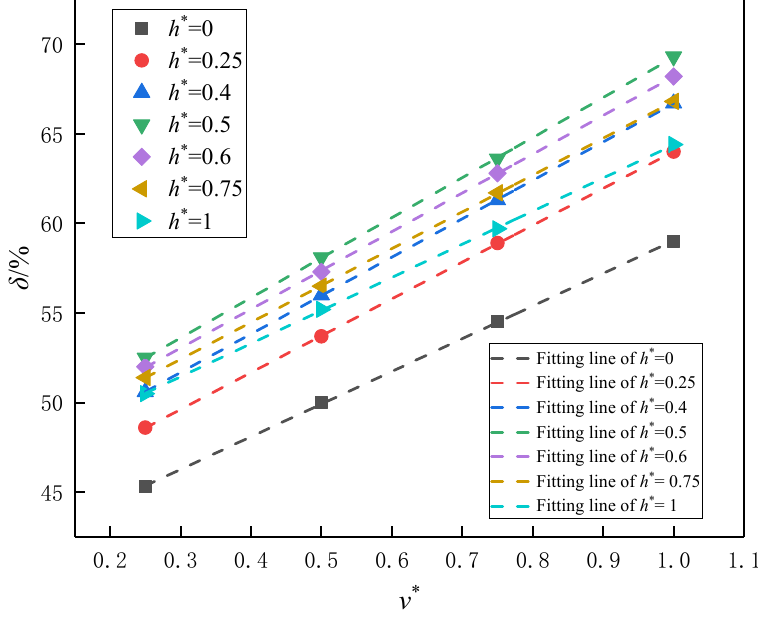
. Q is 3.0 MW. Figure 9. The relationship between δ and v * when Figure 9. The relationship between δ and v * when Q  is 3.0 MW. It can be seen from Figure 9 that δ and v * show a linear positive correlation. The fitted linear relationship is shown in Table